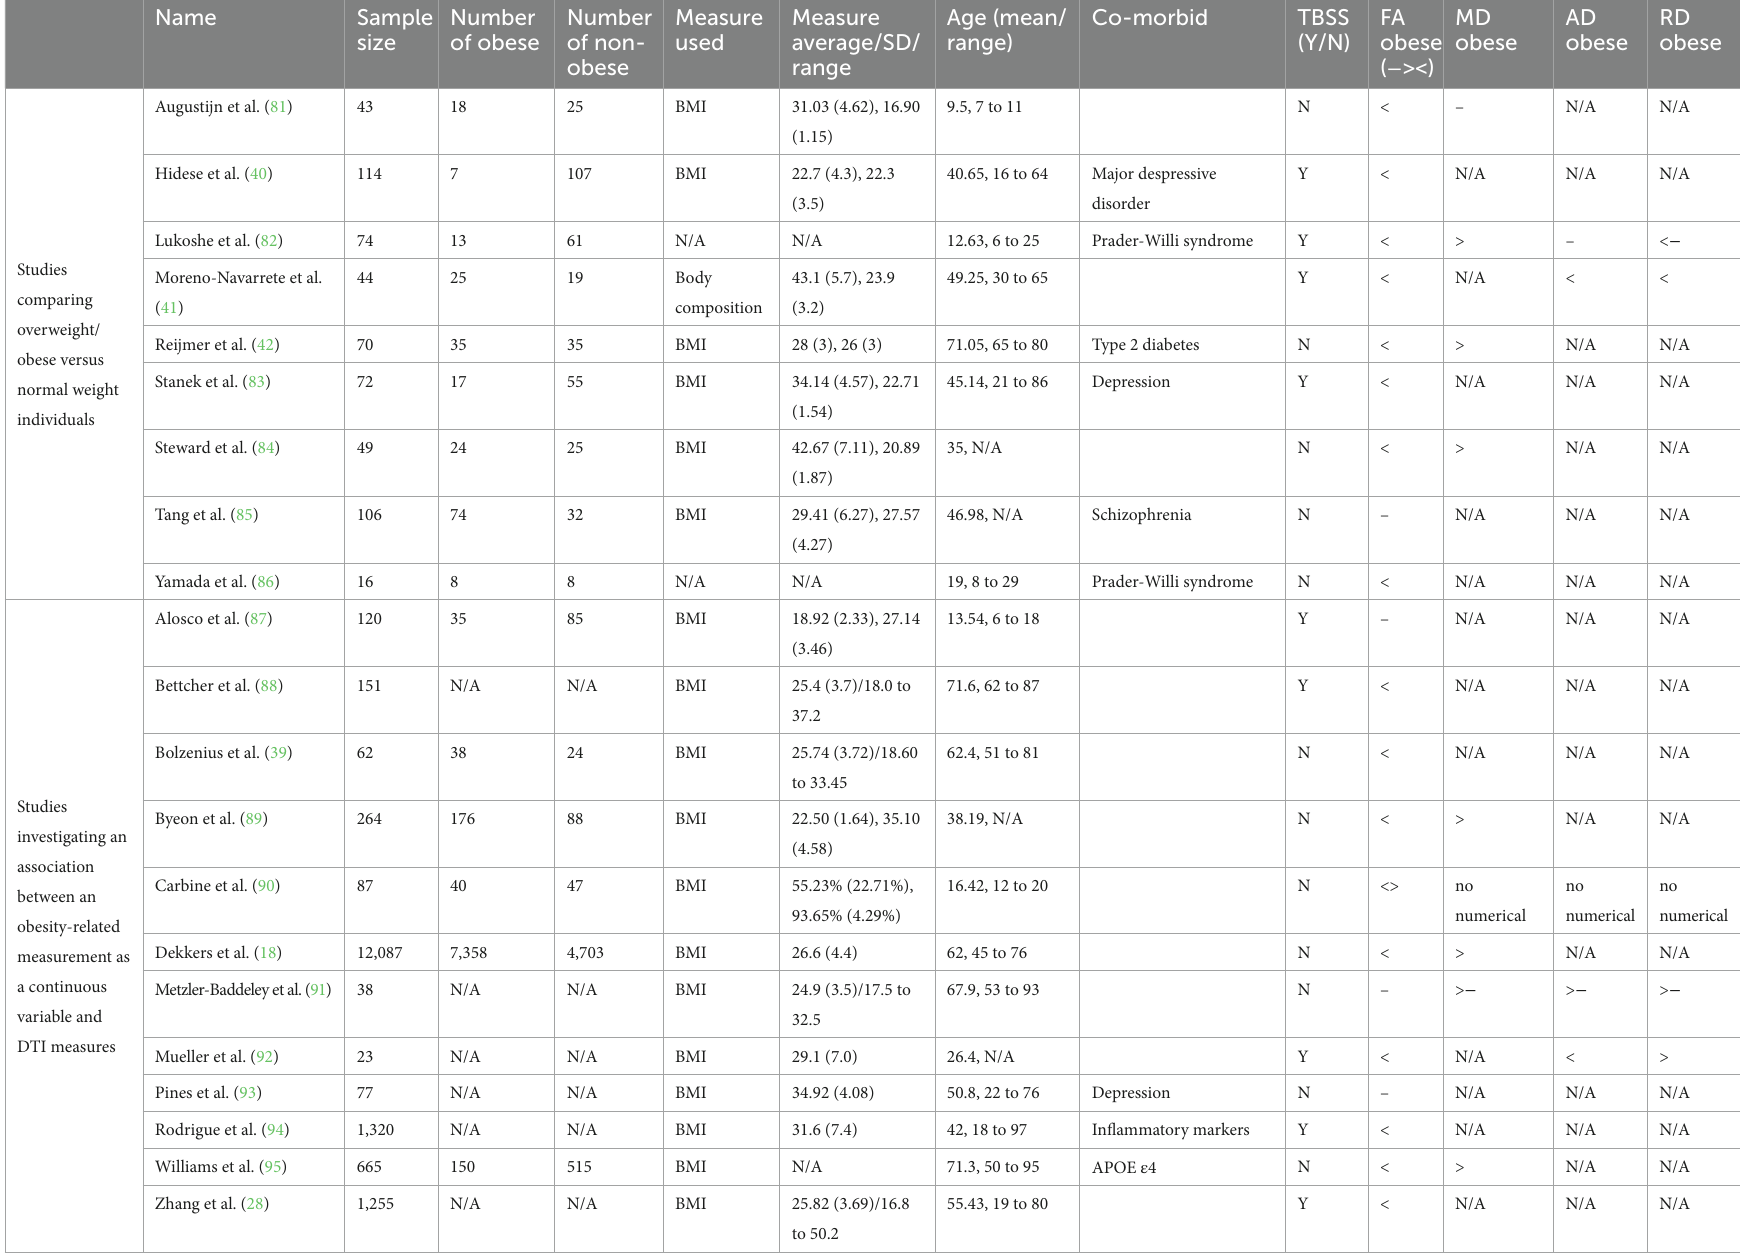
Symbols –, >, and < indicate the direction of results, where – is no difference, < means obese is lower than healthy weight, > means obese is higher than healthy weight, and N/A means no results were